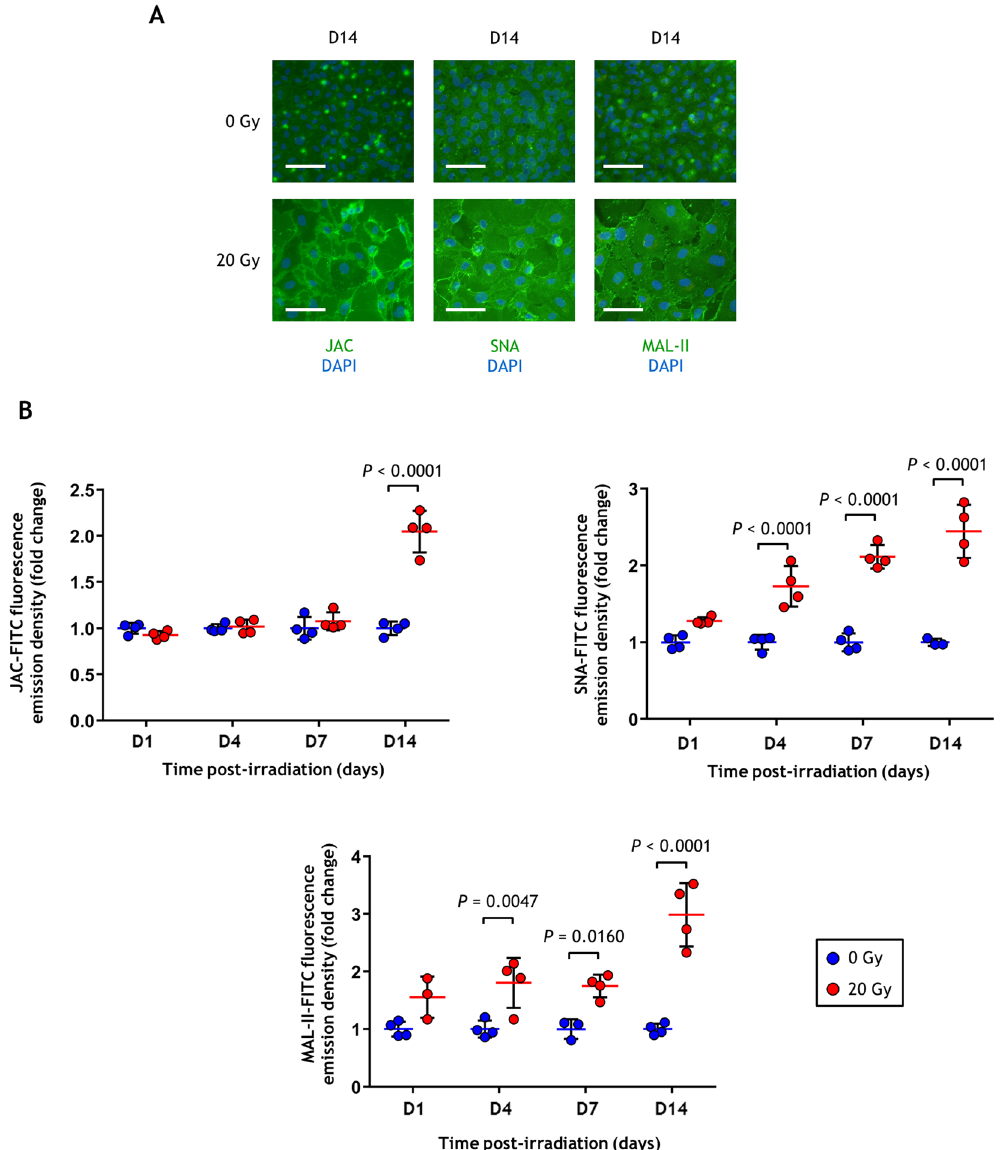
Figure 5. Quantification of JAC, SNA and MAL-II labeling after irradiation. ( A ) Representative fluorescence microscopy images of HUVECs labeled with FITC-JAC, FITC-SNA and FITC-MAL-II. Scale bars: 100 µ m. ( B ) Fold changes of average FITC-JAC, FITC-SNA and FITC-MAL-II fluorescence emission densities determined by fluorescence microscopy (mean + / − SD). Experiments were replicated twice (two different cultures) with n = 4 repeated measures within each replication for each time point. Data represent one of the two experiments. Data were analyzed by two-way